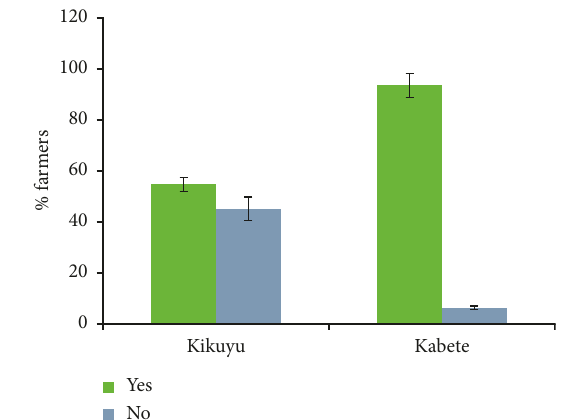
Figure 3: Number of farmers aware and not aware of animal welfare. Table 5: Sources of information on broiler welfare to